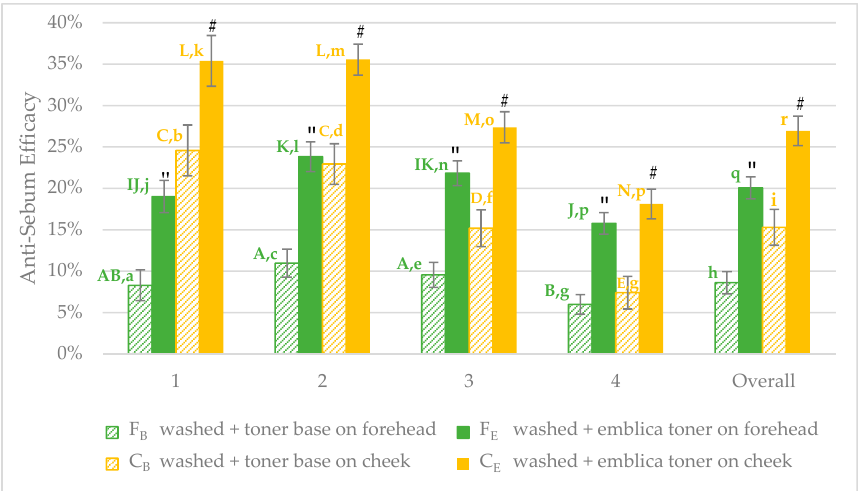
Figure 7. Anti-sebum efficacy of the emblica toners on forehead and cheek skins of treatment compared with the toner base in different periods of 30 volunteers. ” indicates statistically significant differences between the anti-sebum efficacy of emblica toner and that of toner base in the forehead area in the same period ( p < 0.05). # indicates statistically significant differences between the anti-sebum efficacy of emblica toner and that of toner base in the cheek area in the same period ( p < 0.05). Different capital